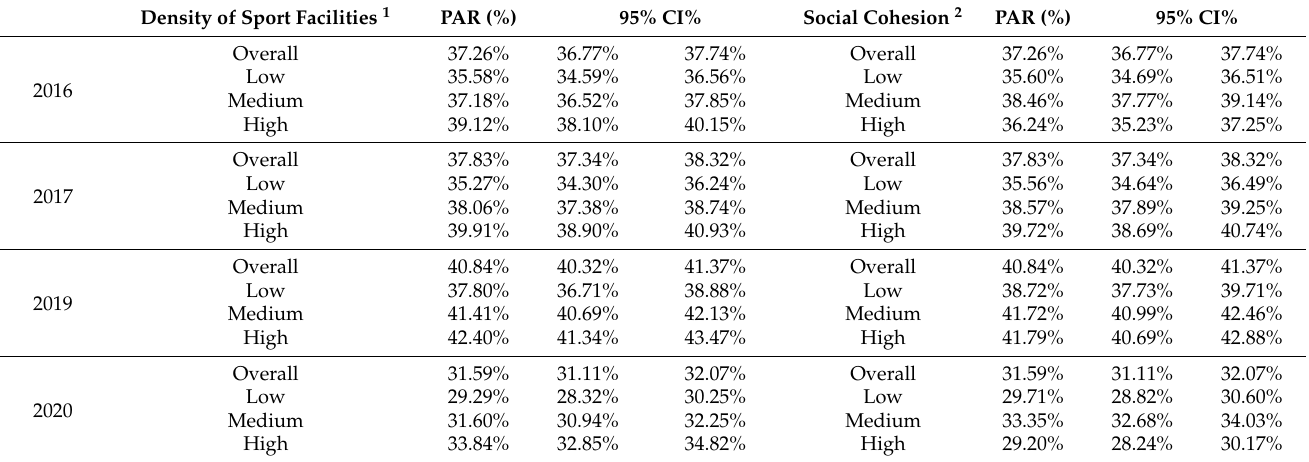
Table 3. Five-year aerobic physical activity adherence rate by community attributes (age- and